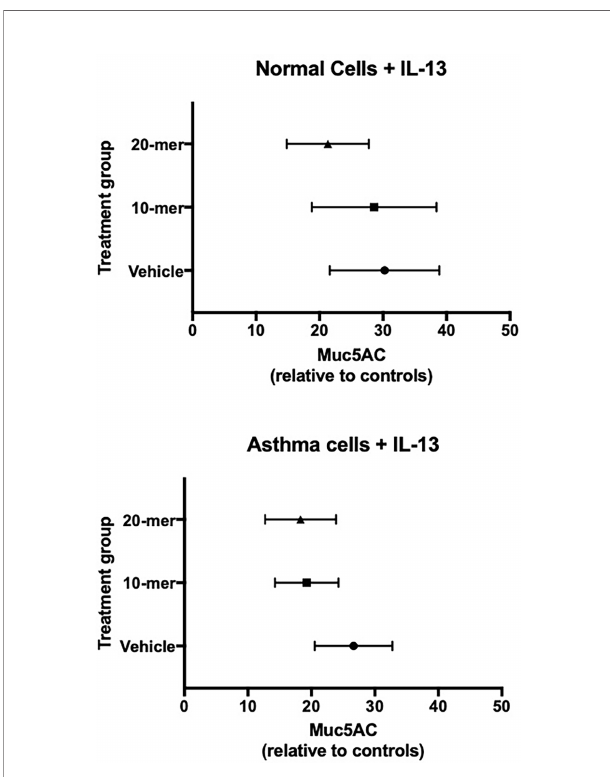
FIGURE 6 | Primary human lung epithelial cells treated with SP-A peptides have reduced IL-13 induced MUC5AC gene expression. Primary human bronchial epithelial cells derived from normal and asthmatic participants were incubated for 30 minutes with either 20-mer or 10-mer SP-A peptide (20 m g/ml) before stimulation with IL-13 (10 ng/ml) for 5 days. When taken together (asthma and normal cells), MUC5AC gene expression was signi fi cantly reduced in the SP-A 20-mer treatment group compared with IL-13 alone